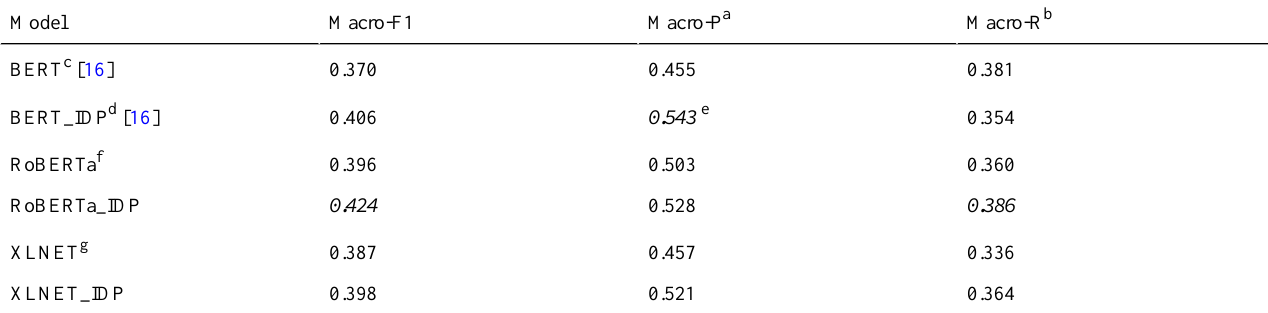
Table 6. Performance of deep-learning methods with different language representation models on level 1, 2 and